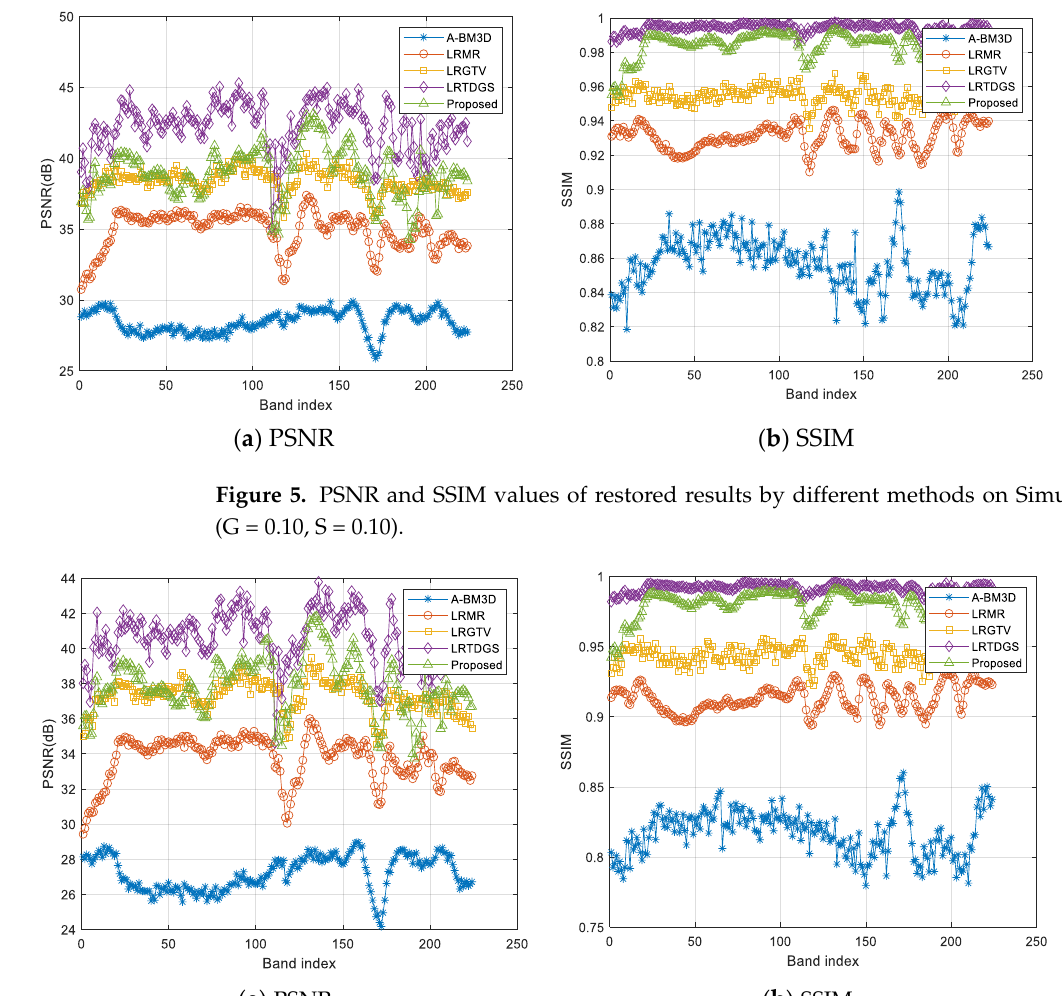
( g ) Proposed Figure 4. Restored results of band 57 on Pavia. From top to bottom: the results under a subcase (the standard deviation of zero-mean Gaussian noise is G = 0.10, and the noise proportion of S&P noise is S = 0.20). Figures 5 – 8 provide the PSNR and SSIM values of each band for the Simu – Indian and Pavia datasets, respectively. As shown in Figures 5 and 6, the proposed algorithm